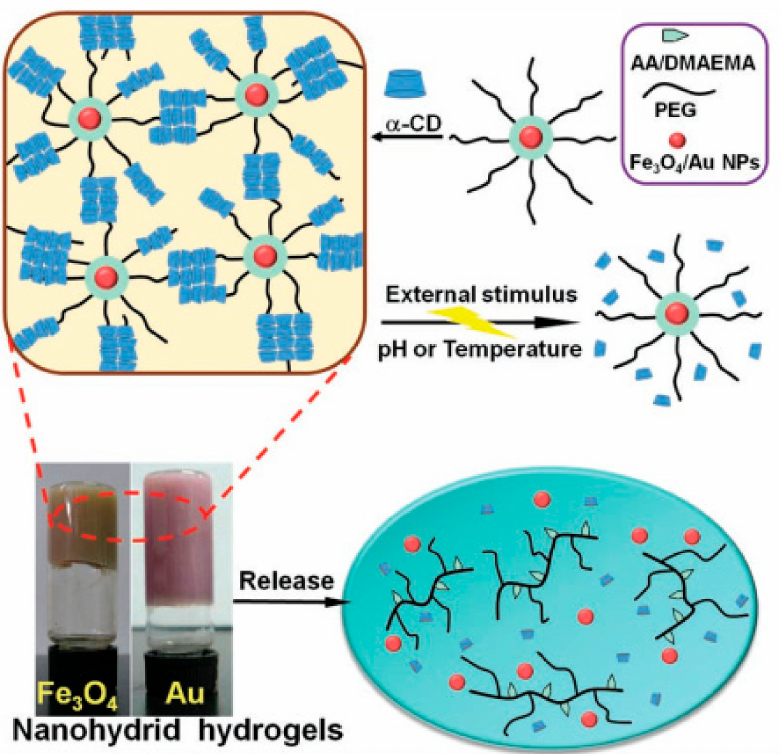
Figure 3. Synthesis of the supramolecular hydrogels hybridized with inorganic MNPs and AuNPs and its release